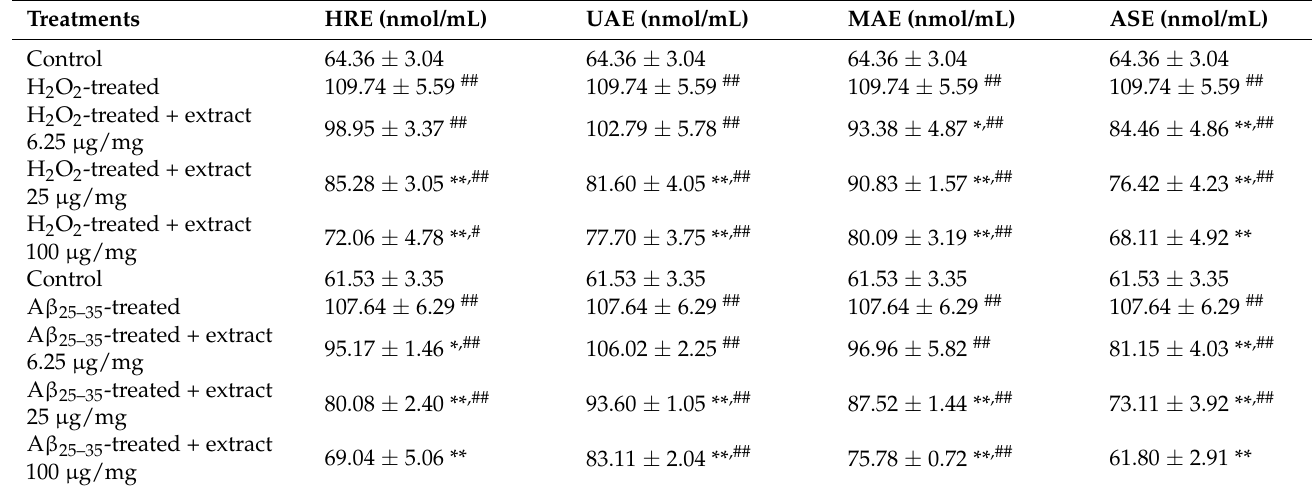
Table 8. Effects of Gardeniae fructus extracts on MDA content of H 2 O 2 - or A β 25–35 -treated PC12 cells (mean ± SD, n =